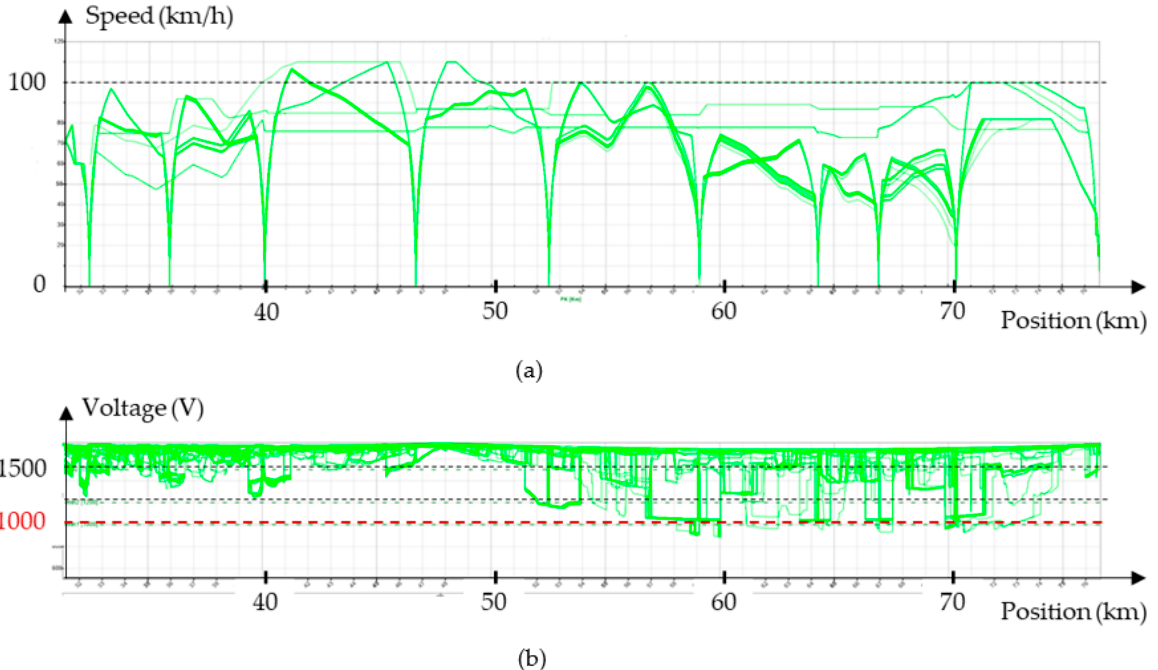
Figure 16. Results in the degraded situation, before adjustment: ( a ) speed; ( b ) catenary voltage of the trains on Line 5.